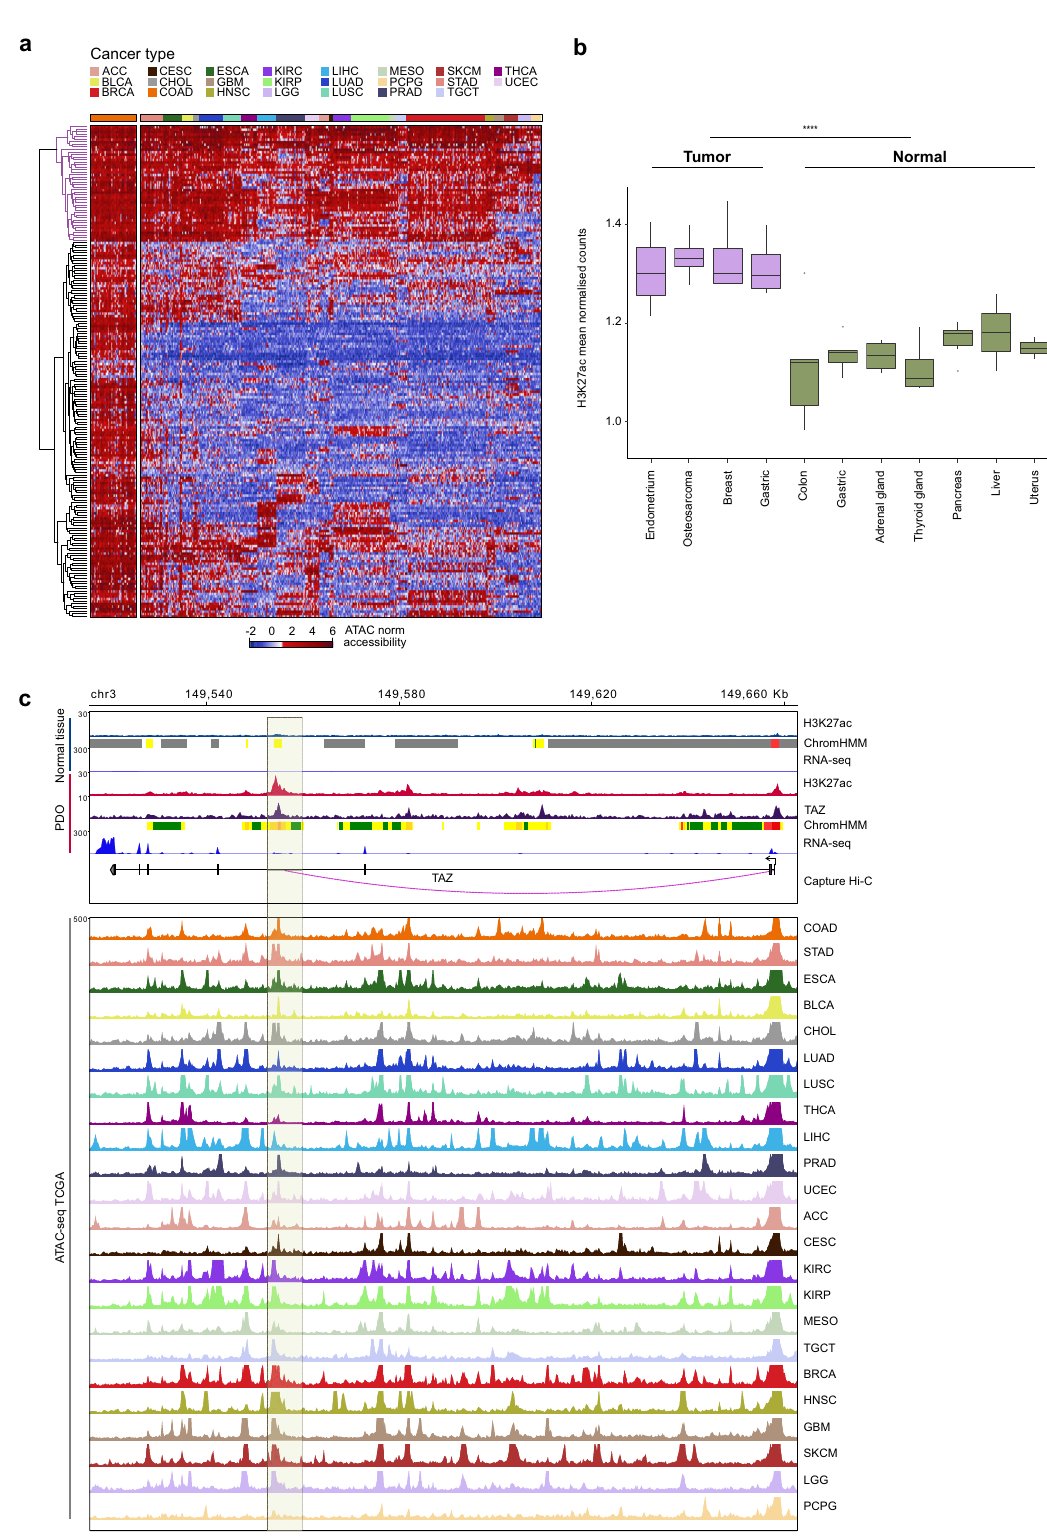
(i.e., MYC) and WNT/ β -catenin signaling 28,33,41 .